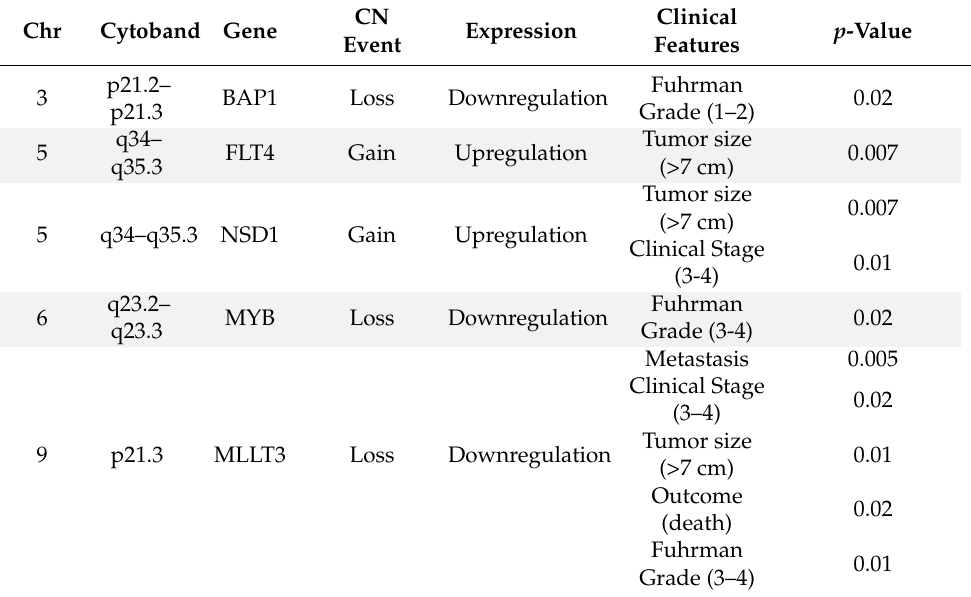
Table 6. Enrichment analysis for genes associated with gene expression through Oncomine